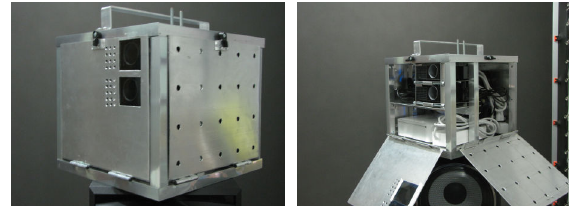
Figure 1. MiniVR system (left) and internal components (right) The MiniVR consists of an aluminum box with approximately 30 cm on each side. It contains everything that is needed to project 3D content on a screen. The idea is that just a power cable connection is required to have all working.